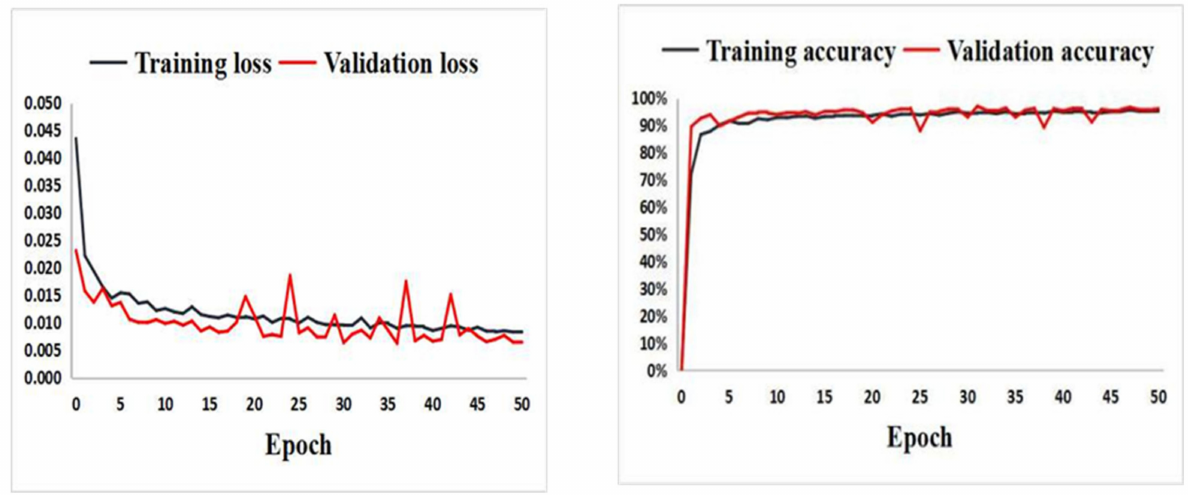
Figure 5. The accuracy and loss for the groups of the uninfected cells and the Mm(WT)-infected cells at 24 hpi in the THP-1